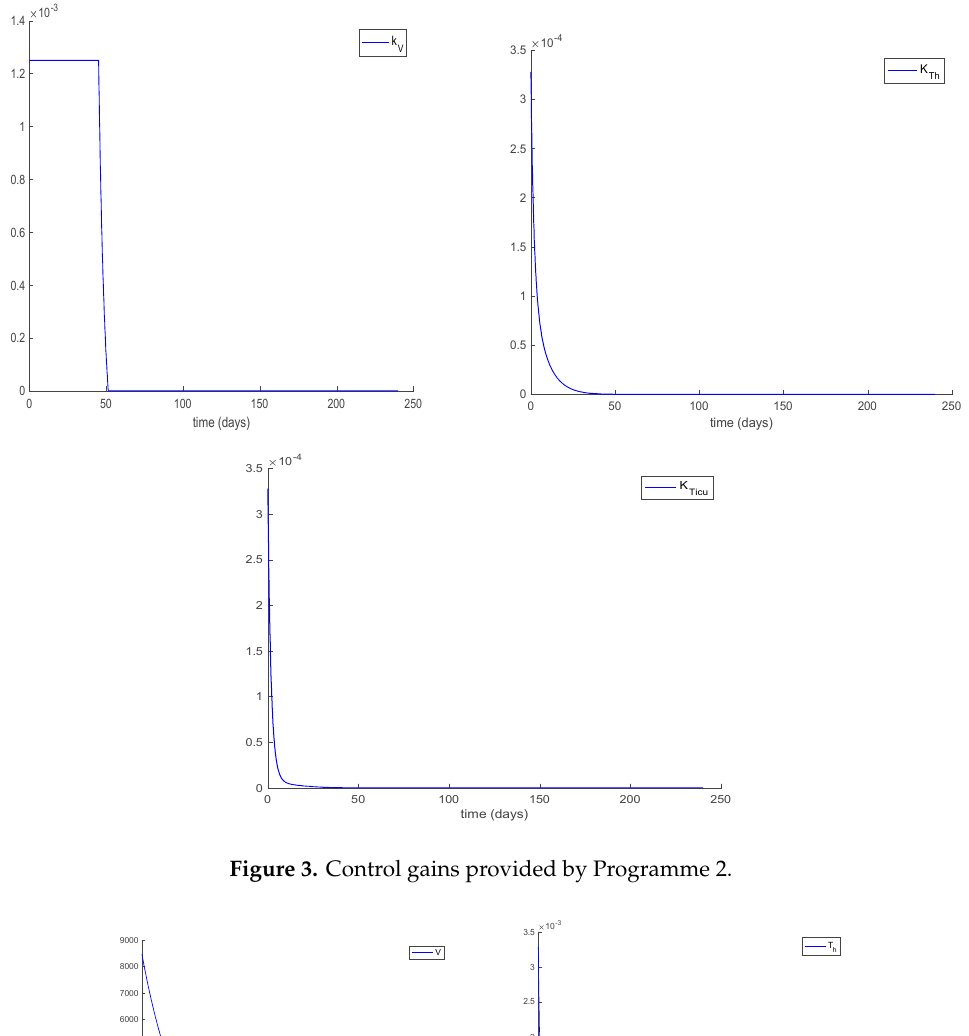
Figure 2. Evolution of the populations of the model when Programme 2 is used.